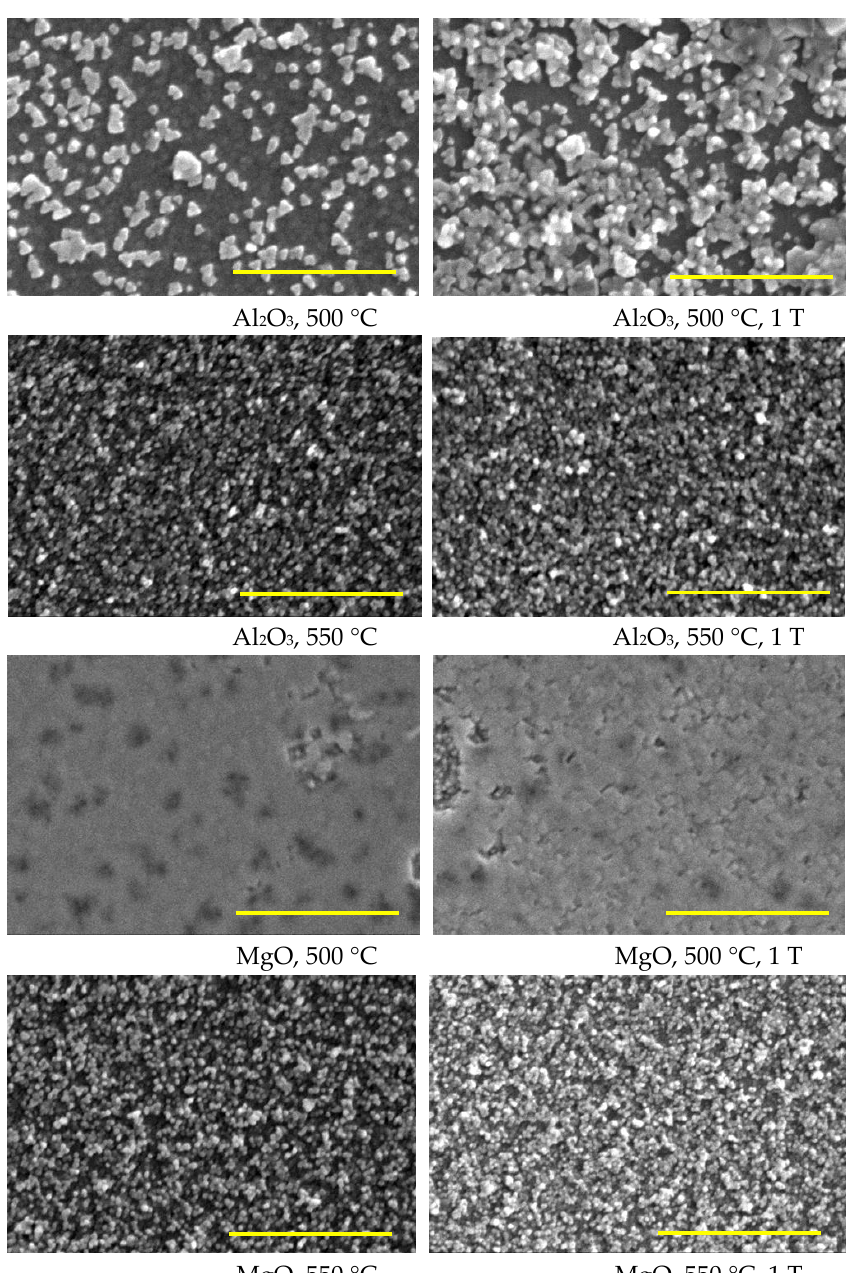
Figure 4. SEM micrographs of the Fe 3 O 4 films grown in Ar+H 2 atmosphere. All scale bars are 1 µm.